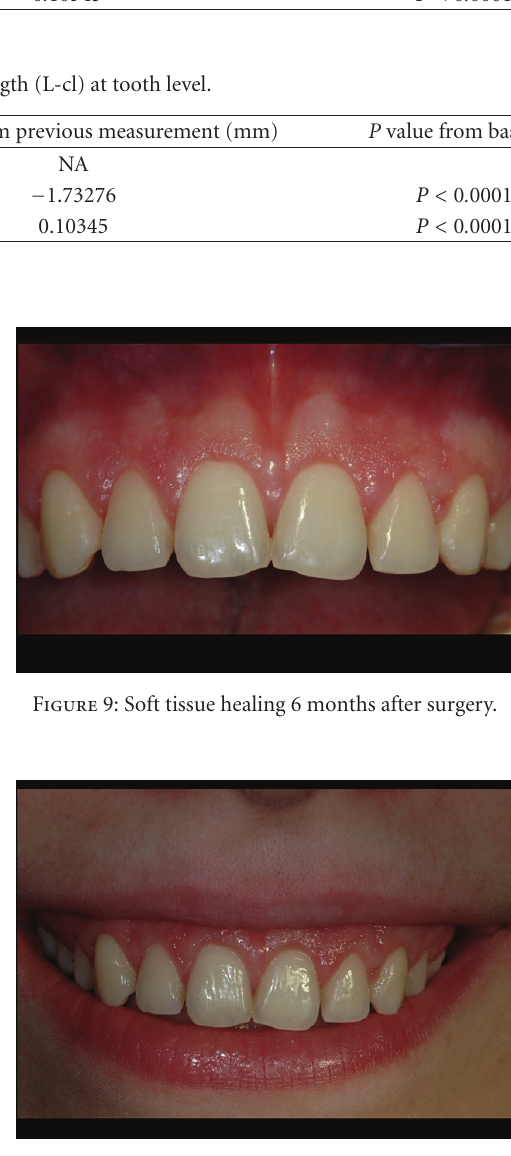
Figure 10: Final patient smile after